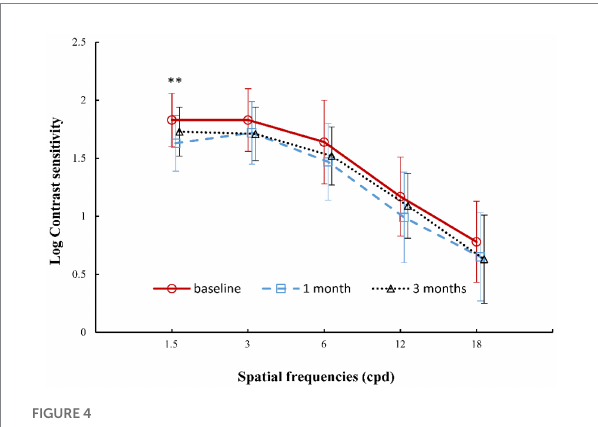
FIGURE 4 Changes in contrast sensitivity function at different spatial frequencies after wearing orthokeratology lenses for 3 months. Error bars represent the standard deviation. **, p < 0.01, significant difference in contrast sensitivity function of 1.5 cpd between baseline and 1 month of wearing the lens, according to post hoc Bonferroni tests. Small horizontal offsets were added to avoid overlapping error-